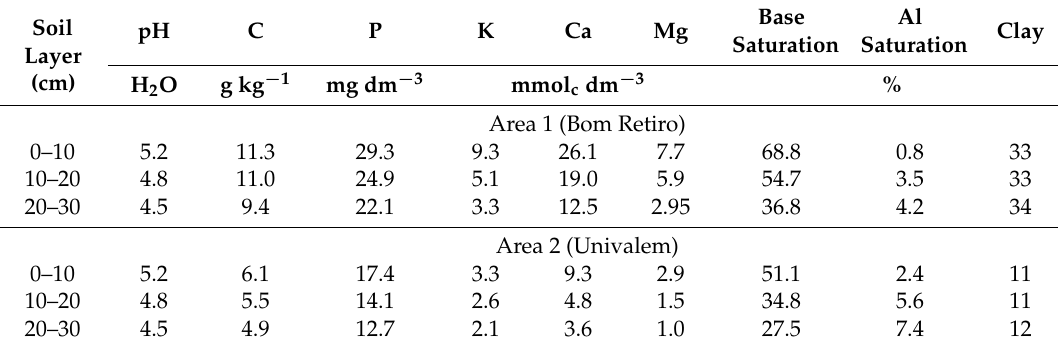
Table 1. Initial characterization of the soils in the experimental areas.